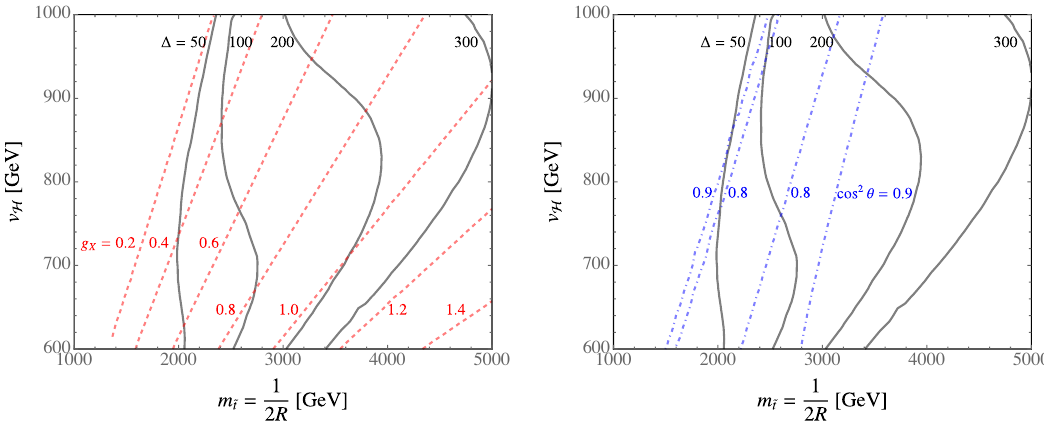
Figure 3 . Left panel: in the Hyperbolic spontaneous symmetry breaking scale ( v stop mass ( m ~ ) plane, contours of the (cid:12)ne-tuning parameter (cid:1) (solid grey), alongside contours t of the required value of g X (dashed red) to realise a leading order prediction of m h = 125 GeV, taking (cid:24) = 0 : 6 and large tan (cid:12) . Right panel: the suppression factor (cos 2 (cid:18) ) of SM-like Higgs signal strengths due to mixing (dot-dash blue), under the same assumptions of the previous